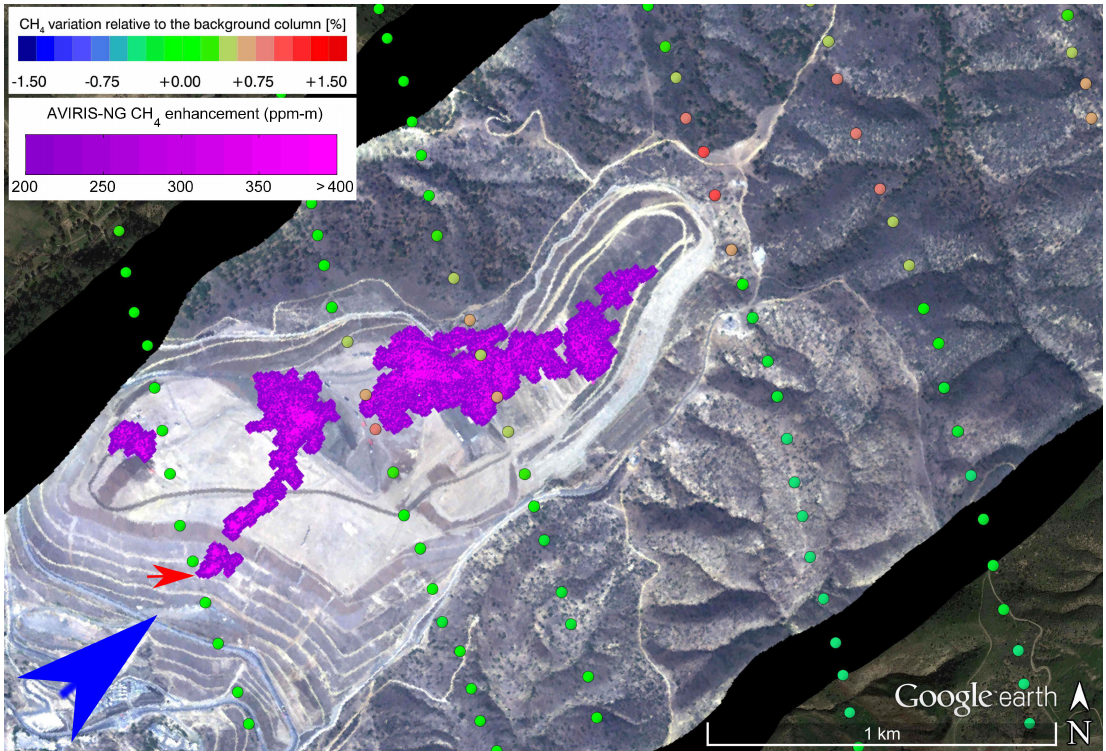
Figure 11. The MAMAP remote sensing (colored circles) and the AVIRIS-NG (pink shaded areas) measurements on 3 September 2014 are shown. The RGB map underneath is also based on AVIRIS-NG observations. For better source attribution, only AVIRIS-NG measurements having a methane column enhancement of larger than 200ppmm are shown. The non-threshold-filtered flight track is depicted in the Fig. 9b. The blue arrow depicts the approximate wind direction. Map underneath visible in the upper left and bottom right corner is provided by Google